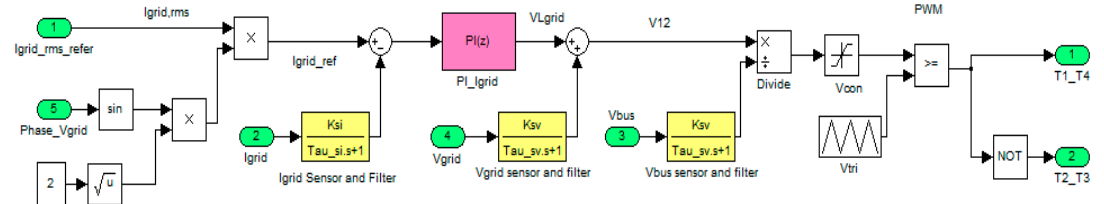
Figure 13. Simulink model of the grid current control for Light-Duty Vehicles.